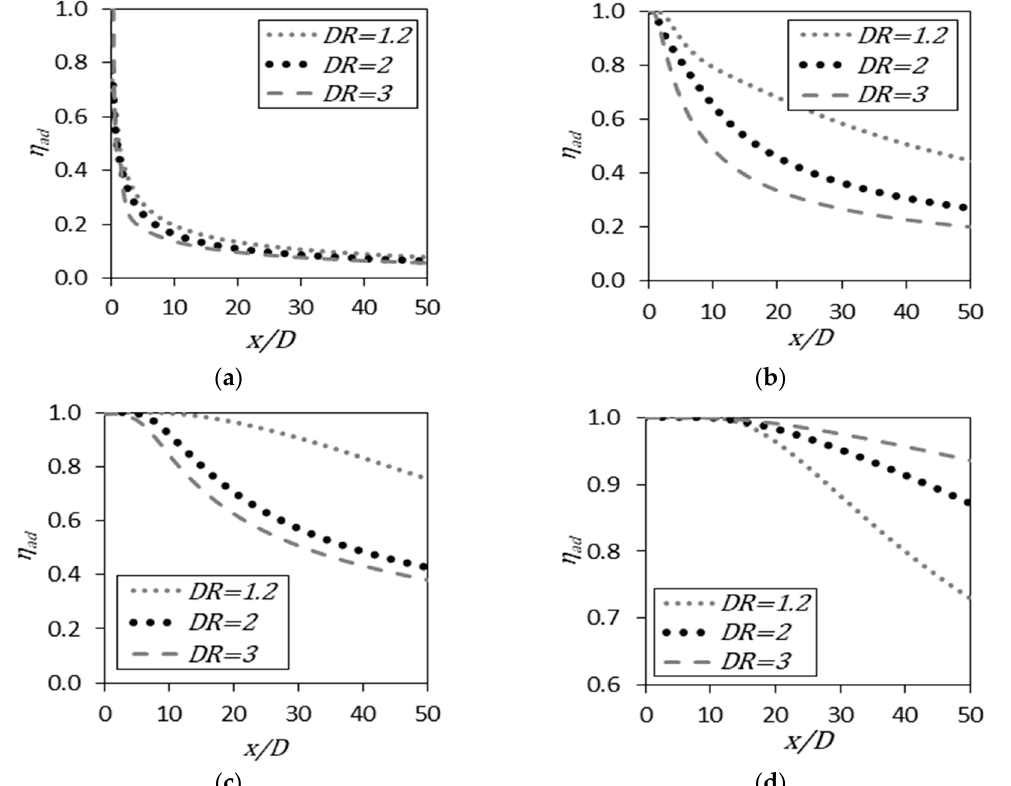
Figure 8. AFCE at injection angle of 30 degree and blowing ratio of (a) 𝑀 = 0.1 , (b) 𝑀 = 0.5 , (c) 𝑀 = 1.0 and (d) 𝑀 = 2.0 .